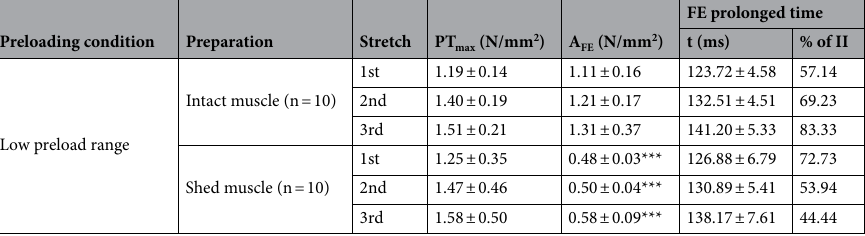
Table 1. The active stretched passive tension and relative force enhancement in low preload cardiac muscle fibres.